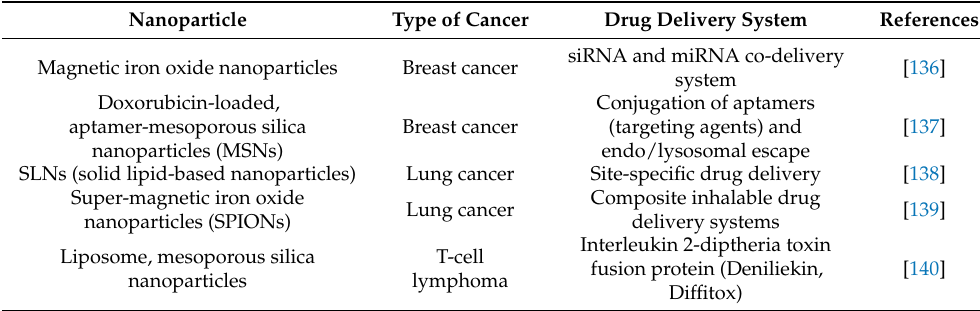
Table 8. Various types of magnetic nanoparticle and their drug delivery systems and applications in various types of cancer.